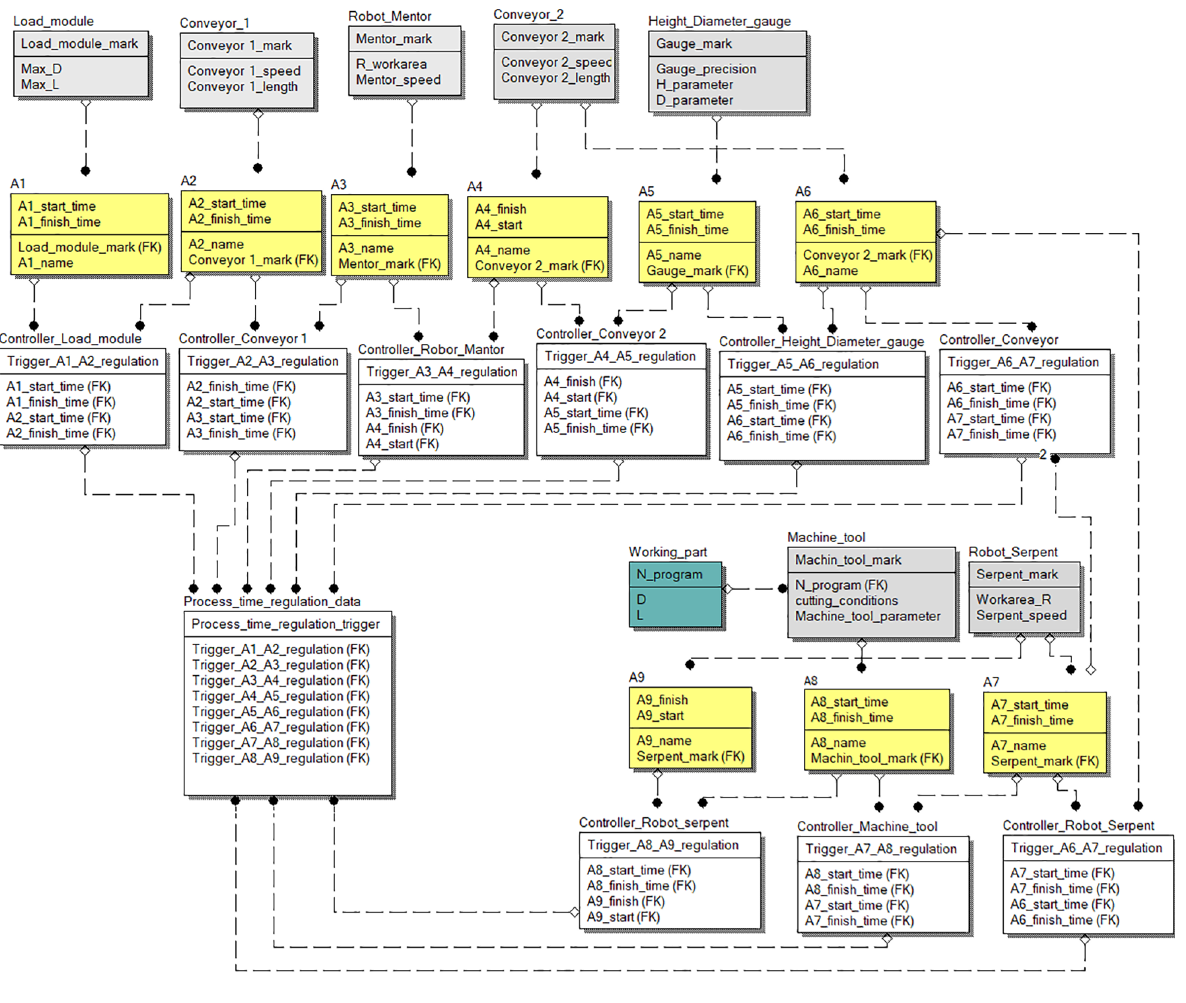
Fig. 8. The database structure of the